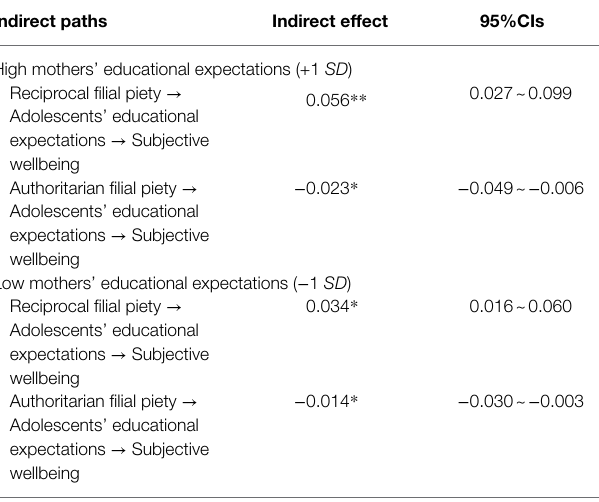
TABLE 3 | Testing moderated mediation using bootstrapping